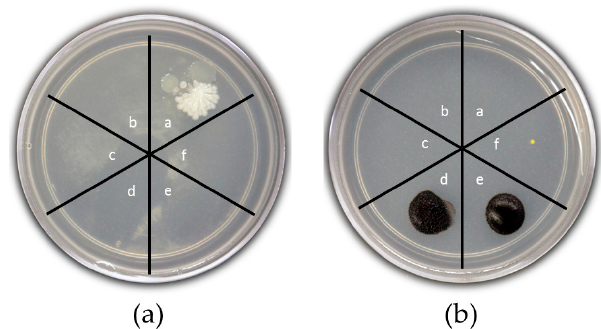
Figure 7. Disinfection of Long Island Sound (LIS) surface water using MACAg. ( a ) The rate of removing the cultivable microbes from a LIS surface water containing 10 5 CFU by 0.5 g of MACAg (0.22%). Sampling (10 µ L) of treated water took place at: space a = 0 min, space b = 3 min, space c = 6 min, space d = 9 min, space e = 12 min, and space f = 15 min; ( b ) Investigation of viable microbes on small samples of MACAg sediment before (spaces d , e ) the wash and in the 1st wash (10 µ L) (spaces c , f ), and 2nd wash (10 µ L) (spaces a , b ).